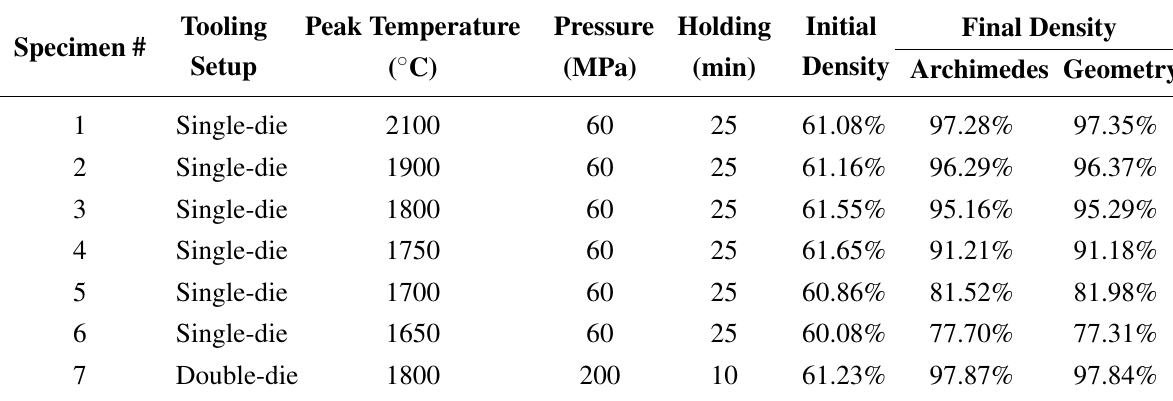
Table 2. Relative densities of sintered